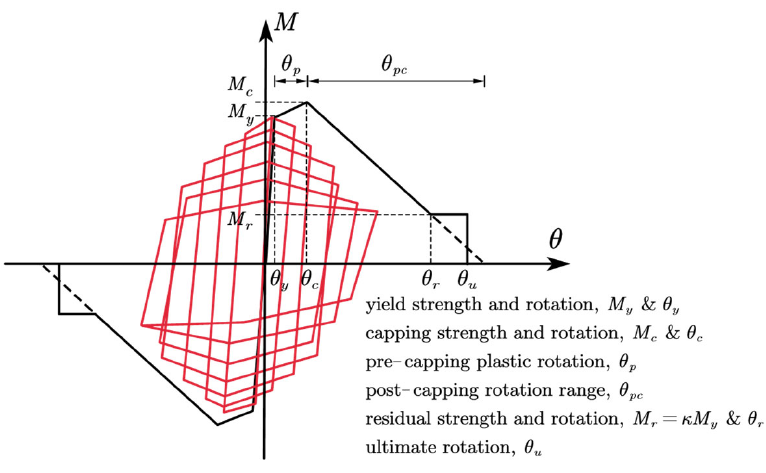
Figure 12. Schematic illustration of finite element models.